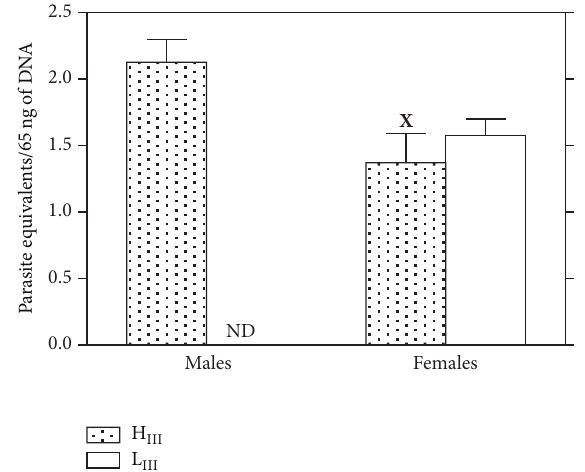
Figure 4: Parasite loads in the cardiac muscles of H III and L III male and femalemice150 daysafter infection (sc)with10 3 trypomastigote forms of the CL strain of T. cruzi . Significant differences of the parasite loads in 65 ng of DNA isolated from cardiac tissue are indicated: X 𝑃 = 0.0125 (between H III males and H III females); ND: not determined (all male L III mice die in the acute